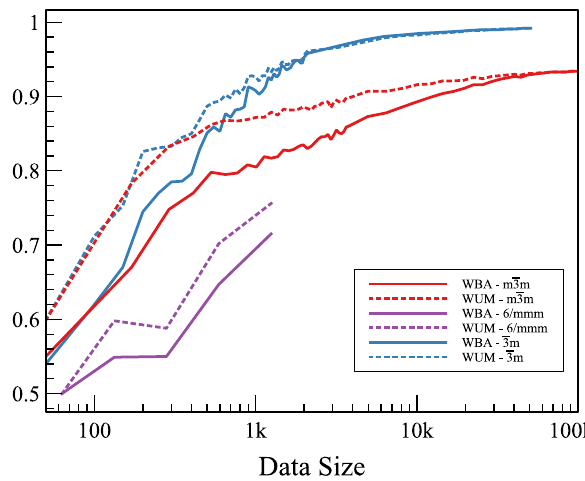
Figure 6. The data size dependency of the classification model. The effect of the data size is evaluated using the weighted balanced accuracy and the unit normalized MCC for the cubic ( m 3 m point group), hexagonal (6/ mmm point group) and trigonal ( 3 m point group) crystal systems. The scores of the weighted unit normalized MCC are better than the weighted balance accuracy and saturate faster for all point group symmetries. The metrics become closer at saturation region and vary from one symmetry to another. Moreover, the 3 m and m 3 m point groups maintain approximately equal scores in the region of very small data size to a certain point then they split. The curves of the 3 m point group are the steepest and highest ones as they attain saturation (close to 1) after approximately 2 thousand data points. For the m 3 m point group, data points beyond 20 thousand result in both metrics exceeding 0.9. Finally, the data of 6/ mmm point group are not sufficient to elucidate the full picture, however, 6/ mmm point group is the lowest scoring symmetry and demands more data to reach at least beyond 0.8